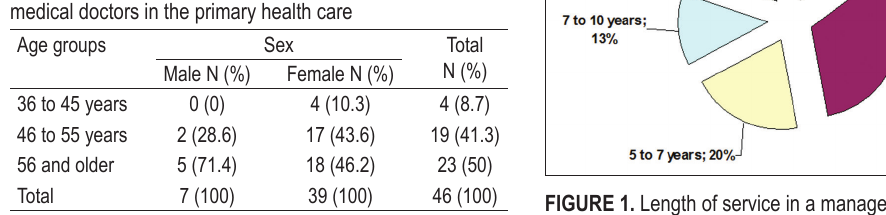
TABLE 1. Demographic profile of surveyed managers ‑